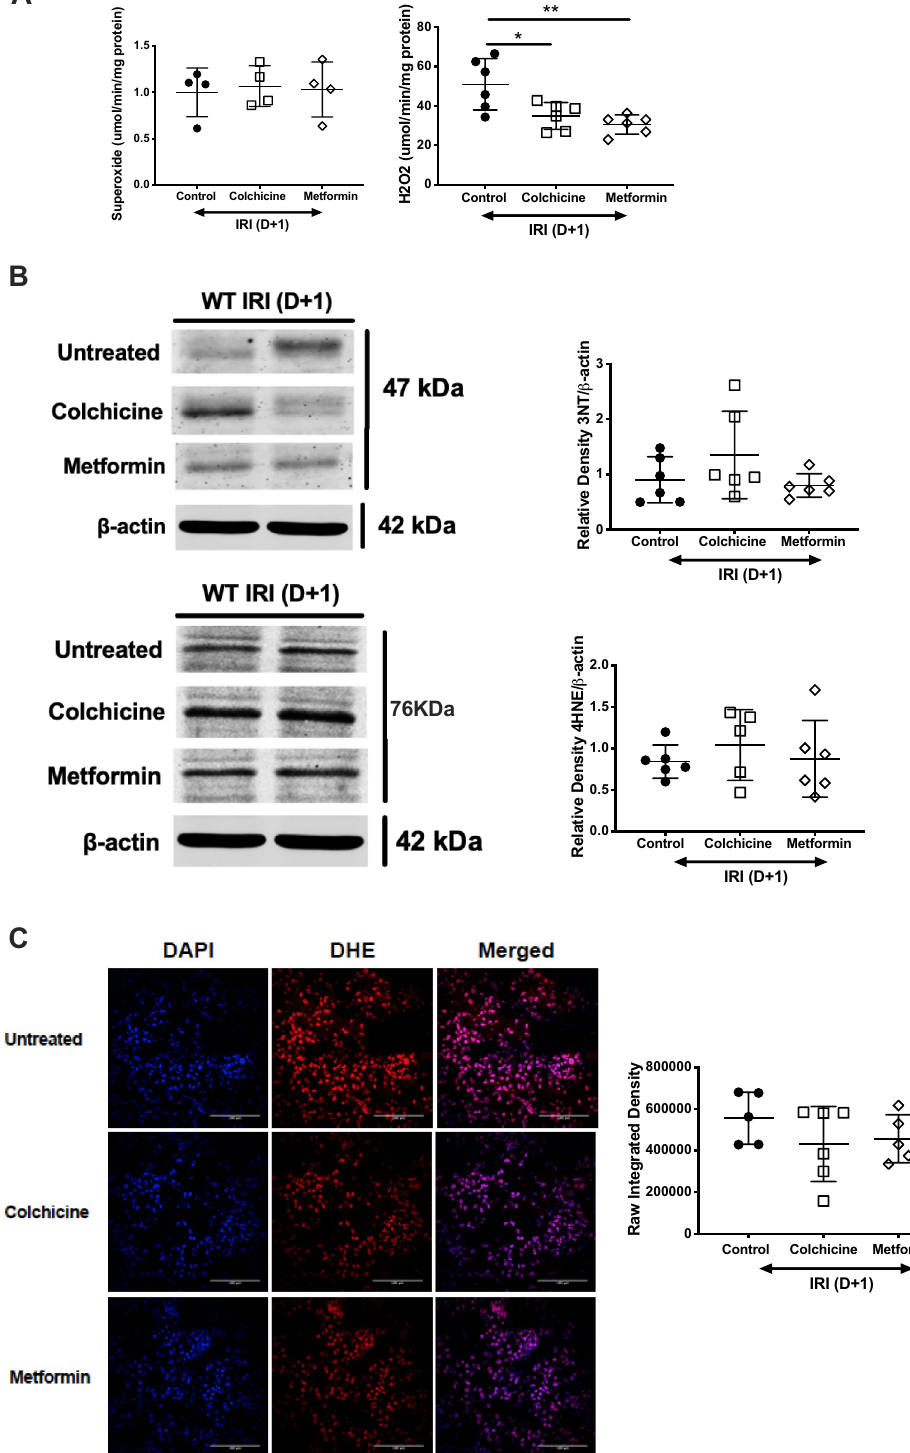
Figure 2. Colchicine and metformin do not limit AKI but altering oxidative stress. Age-matched male C57BL/6 mice were administered vehicle control (phosphate buffered saline, PBS), colchicine or metformin, and then subjected to bilateral renal ischemia followed by 24 h reperfusion. Kidney tissue homogenates were prepared for ( A ) quantification of superoxide and hydrogen peroxide and ( B ) protein was separated by SDS-PAGE to measure ROS-mediated changes. Representative Western blots and combined densitometry for 3-nitrotyrosine and 4-hydroxynoneal is presented as the mean ratio of target protein to β-actin ± SD; * p < 0.05, ** p < 0.01, *** p < 0.001. Kidney sections were stained with dihydroethidium (DHE) and imaged by immunofluorescence. ( C ) Representative photomicrographs are shown, original magnification 20 × , scale bar is 100 μm. Intensity of staining was analysed. All data are presented as mean ±